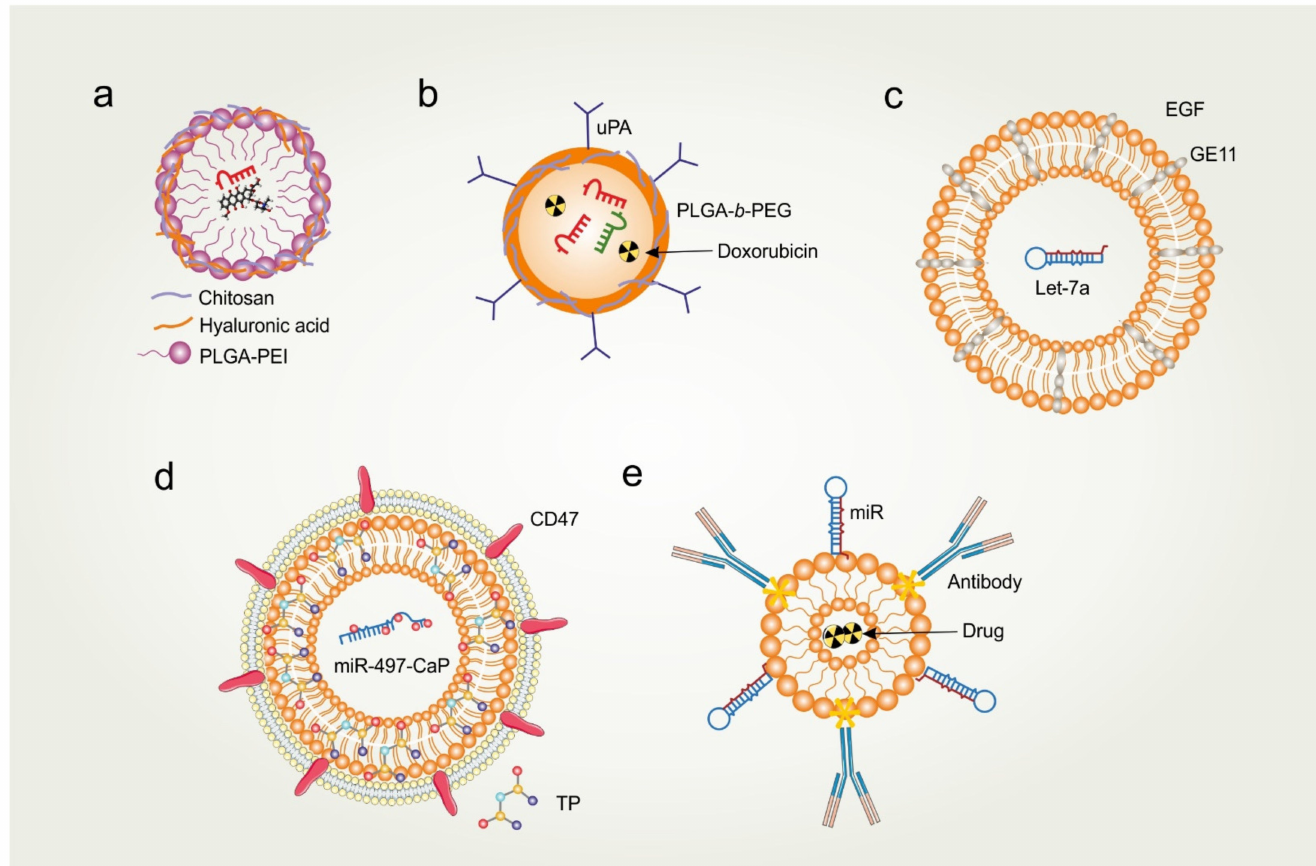
Figure 4. Extracellular miR-based RNA therapeutics. ( a ) A hyaluronic acid (HA)-chitosan decorated or HA-polyethylenimine-poly(d,l-lactide-co-glycolide) (PEI-PLGA) nanoparticle (NP) system devel- oped for targeted co-delivery of doxorubicin and miR-34a or miR-542-3p. ( b ) AntagomiRs loaded to urokinase plasminogen activator (uPA)-peptide and polylactic-co-glycolic acid-polyethylene glycol (PLGA- b -PEG) polymer NPs for targeted delivery of antagomiR-10b and antagomiR-21 to uPAR+ cancer cells. The NPs can also be loaded with anti-cancer drugs such as doxorubicin. ( c ) Modified exosomes express the transmembrane domain of platelet-derived growth factor receptor fused to the GE11 peptide or EGF on their surface to deliver Let-7a to EGFR-expressing cancer cells in vivo. ( d ) Hybrid nanoparticles (HENPs) made of synthetic liposomes with encapsulated triptolide (TP) fused with cancer exosomes with CD47 for targeted delivery. Calcium phosphate (CaP)-adsorbed miR-497 incorporated into the NPs. ( e ) Synthetic exosomes designed to deliver adjuvant therapy of miR mimetics with anti-cancer drugs. The surface of these exosomes can be coated with adsorbed miR mimic/antagomiR and an antibody targeting a specific antigen of target